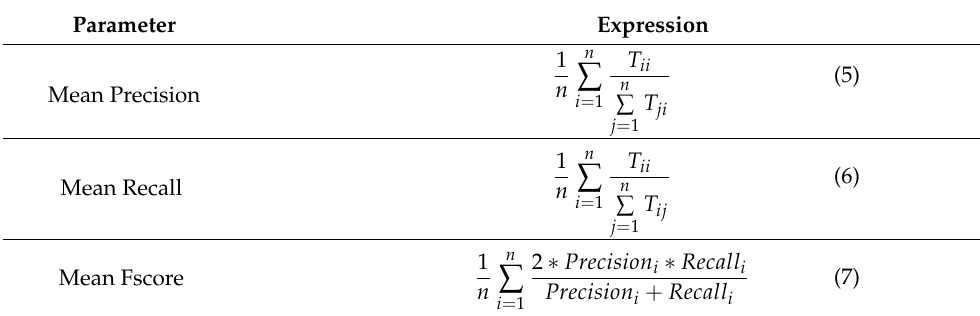
Table 2. Evaluation